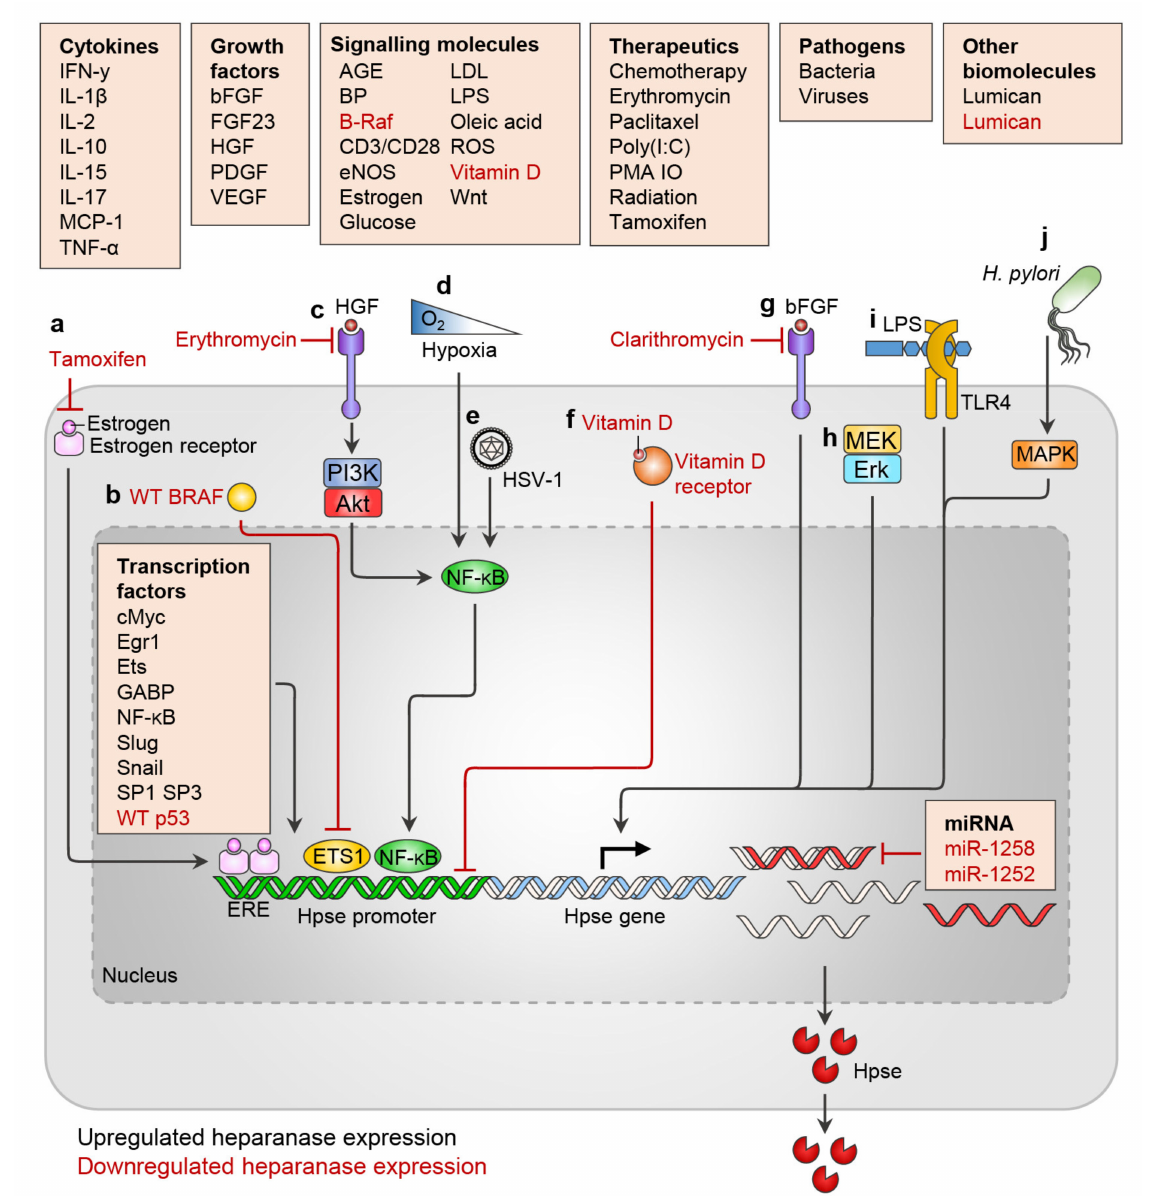
Figure 1. Regulators of heparanase expression. Heparanase expression is positively and negatively regulated by a number of cytokines, growth factors, signaling molecules, therapeutics, pathogens, transcription factors, and miRNA. ( a ) Estrogen binding to the estrogen receptor allows binding to the estrogen response element within the heparanase promoter and heparanase upregulation. ( b ) Wild-type BRAF inhibits heparanase expression by directly repressing ETS1, a transcription factor known to promote heparanase expression. ( c ) HGF, via the PI3K/Akt pathway, activates NF- κ B to induce heparanase expression. Erythromycin inhibits HGF (and PDGF)-induced heparanase upregulation. ( d ) Hypoxia, and ( e ) HSV-1 upregulate heparanase via NF- κ B. ( f ) Vitamin D activates the vitamin D receptor which directly binds and inhibits the heparanase promoter. ( g ) bFGF upregulation of heparanase can be inhibited with clarithromycin. ( h ) Activation of the MEK Erk pathway upregulates heparanase. ( i ) LPS binding to TLR4 upregulates heparanase. ( j ) H. pylori infection upregulates heparanase via MAPK. ERE, estrogen response element; Hpse,